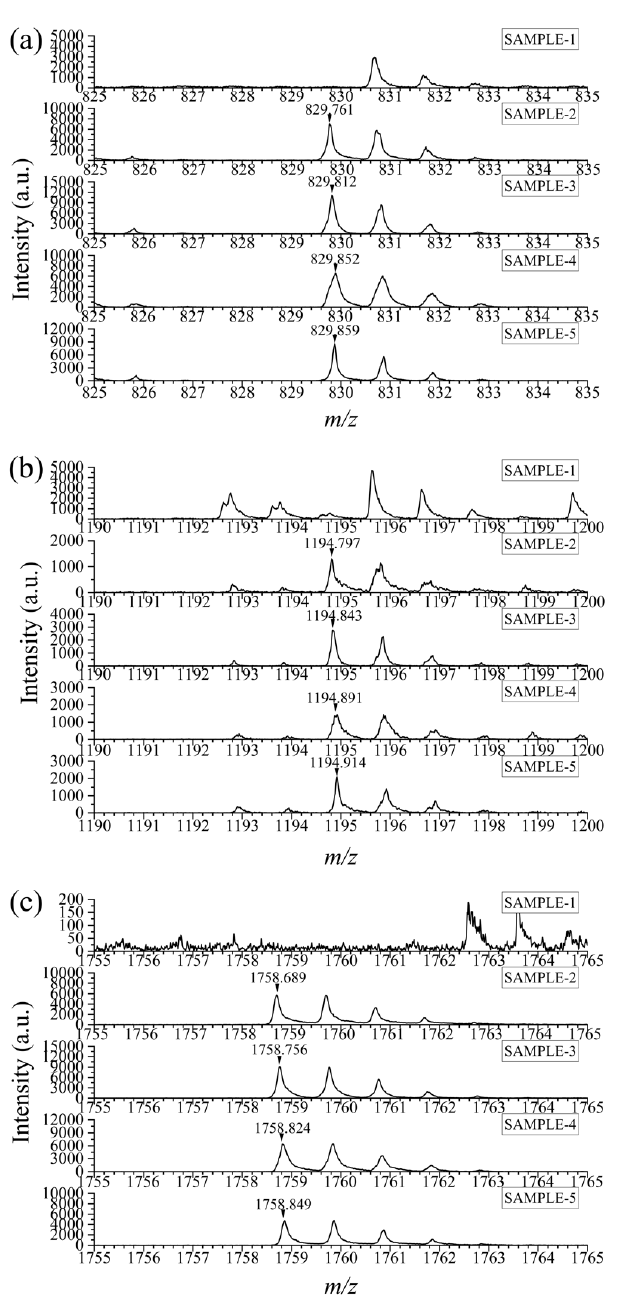
Figure 4. The mass spectra of selected specific peptides in goat milk samples from five brands. m / z = 830 ( a ), 1195 ( b ), 1759 ( c